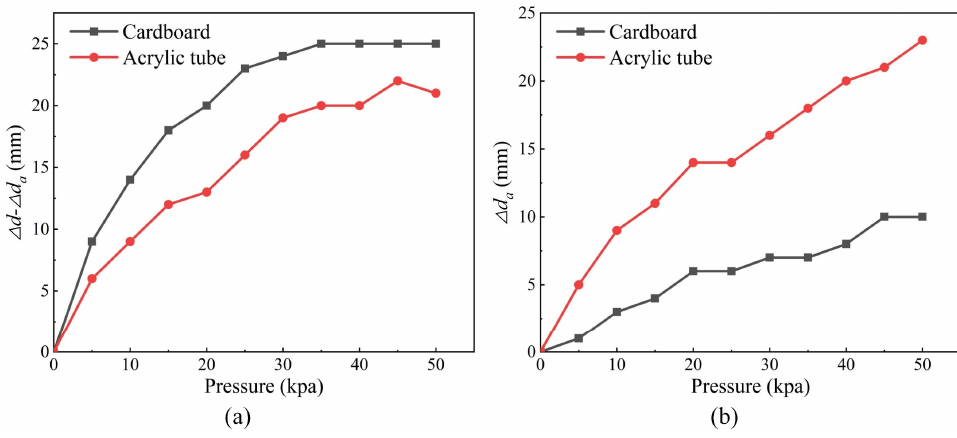
Figure 7. The robot’s motion performance with different surfaces ( a ) The real step length with different surfaces; ( b ) The sliding length with different surfaces. Table 3. The robot’s motion efficiency with different